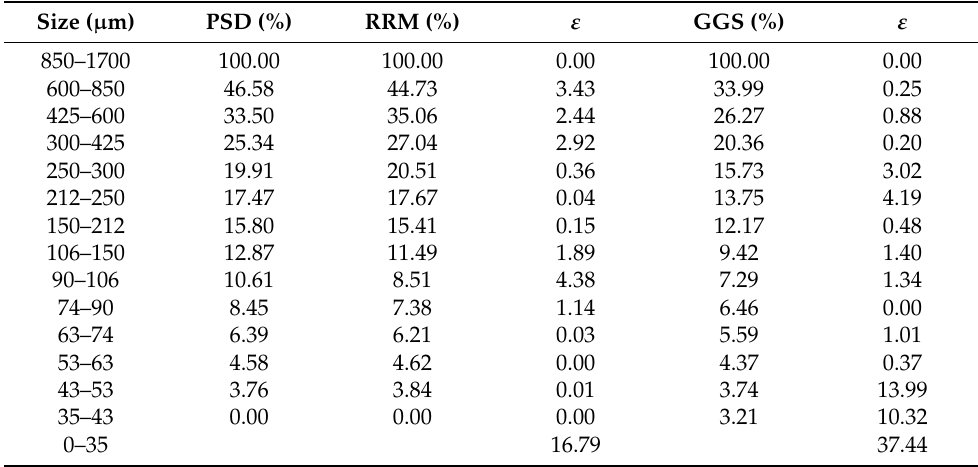
Table A1. Adjustment results of the PSD and PSDM with least squares, for feed.